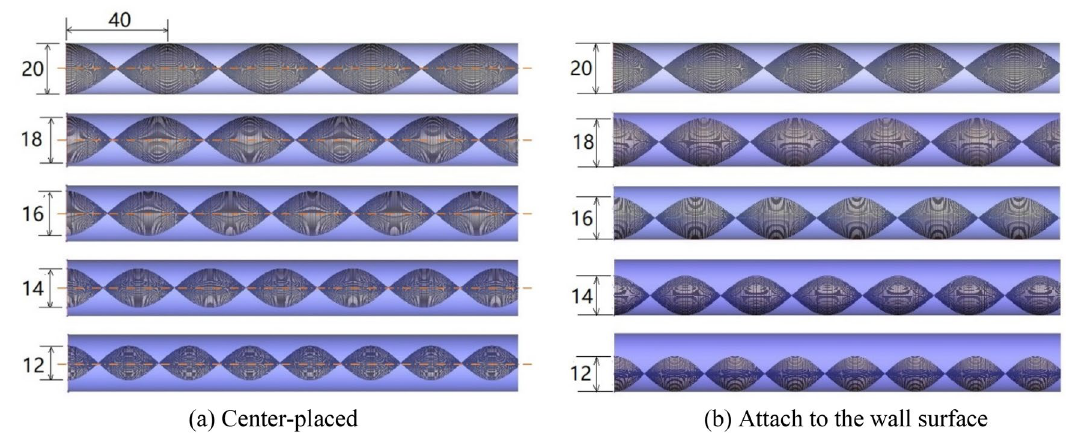
Figure 2. Twisted tape inserts with different